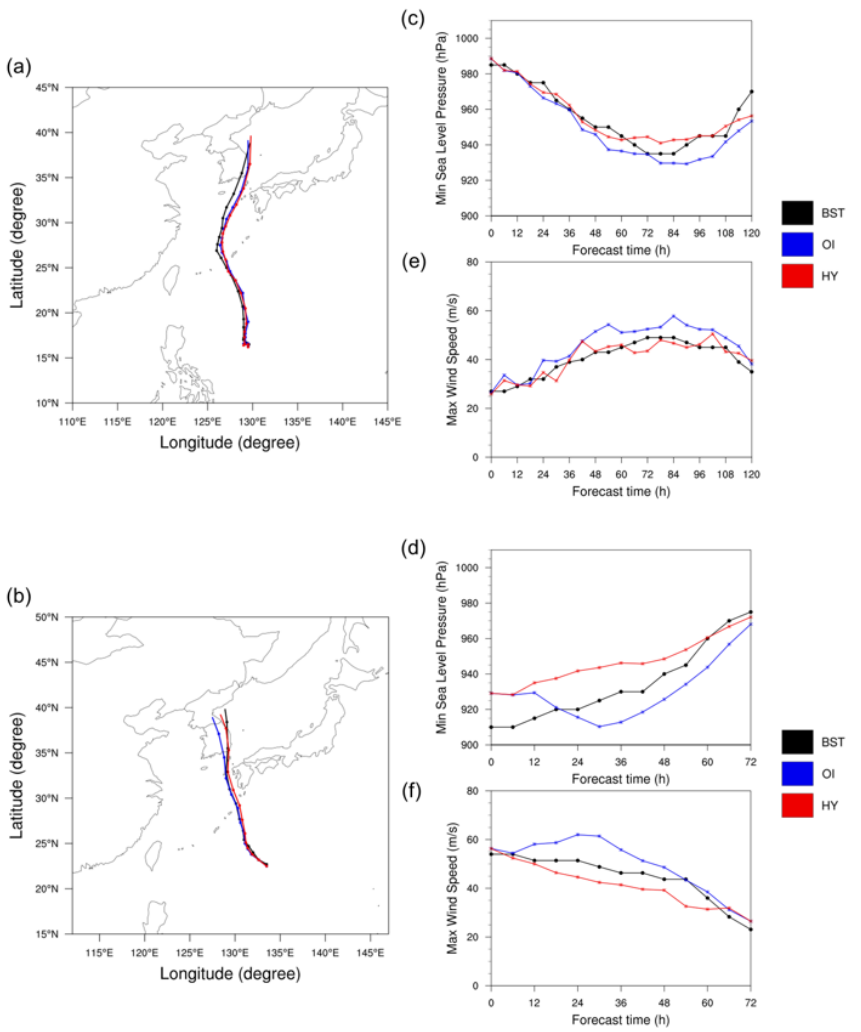
Figure 3. Simulated ( a ), ( b ) track; ( c , d ) minimum sea-level pressure (hPa; MSLP); and ( e , f ) maximum wind speed at 10 m (m s − 1 ; MWS) for typhoons Maysak (initialized at 00 UTC 29 August 2020; five-day runs) and Haishen (initialized at 12 UTC 4 September 2020; three-day runs), respectively. Black: the Regional Specialized Meteorological Center (RSMC) best track (BST) data; blue: OI run; red: HY run.